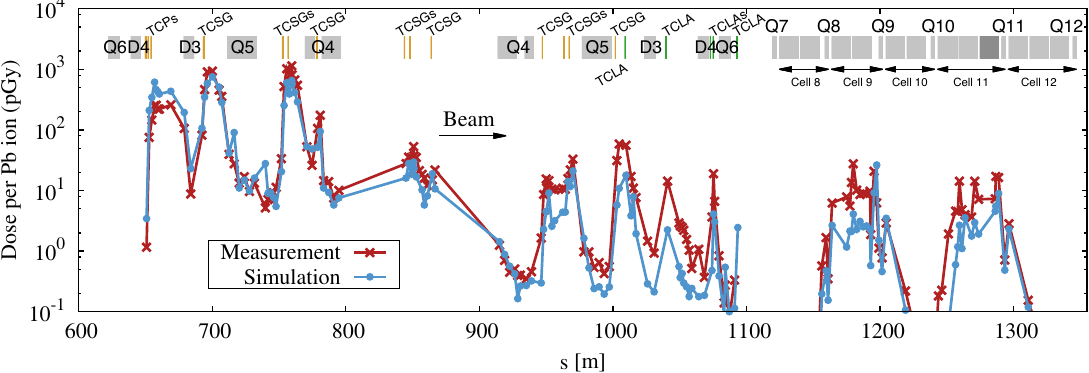
FIG. 15. Comparison of simulated and measured BLM signals in the IR7 cleaning insertion, the adjacent DS (cells 8 – 11) and the first arc cell (cell 12). The beam direction is from the left to the right. The signals are expressed per 208 Pb 82 þ ion lost in the collimation system. The positions of primary and secondary collimators (TCPs and TCSGs), tungsten absorbers (TCLAs), dipoles (D3 and D4), and quadrupoles (Q4-Q12) are illustrated on the top. The statistical error of simulation results is generally smaller than 10% for dose values above 10 pGy but can be significantly larger for dose values below 10 pGy where a lower amount of losses